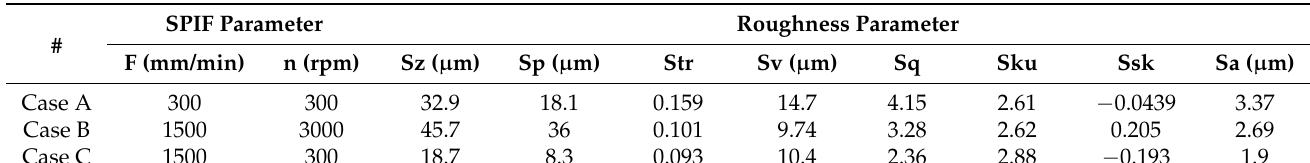
Table 3. Litecor ® Stiffening ribs sheets roughness parameters.